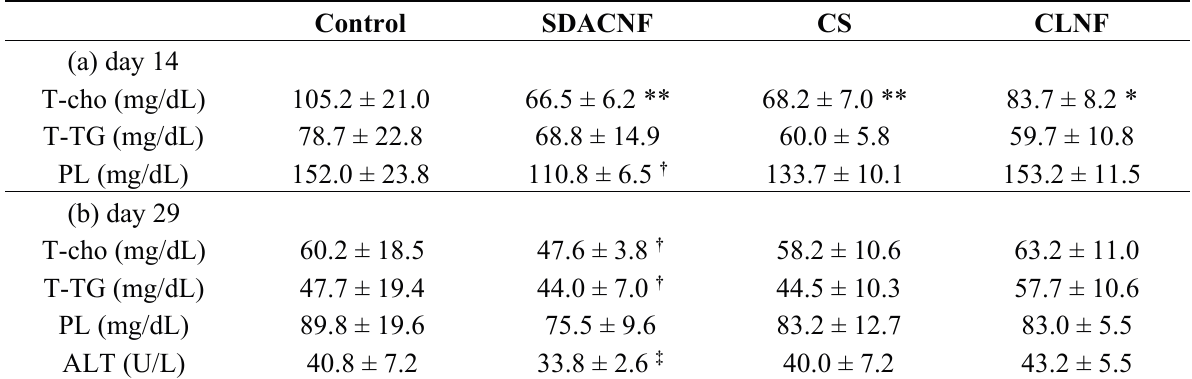
Table 3. Effects of oral administration of SDACNFs on serum chemistry. Each table indicates the results of serum chemistry on day 14 ( a ), and on day 29 ( b ). Data are presented as mean ± standard error. **: p < 0.01 compared with the control